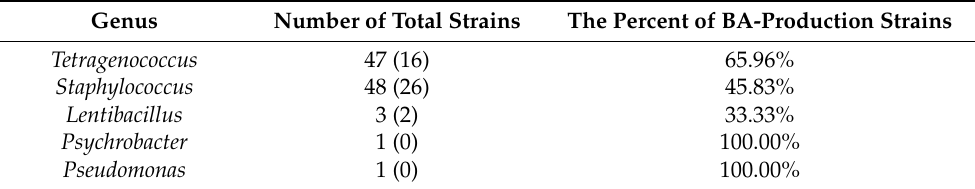
Table 2. Percentage of strains with BA production activities, shown in vitro by the different bacteria species isolated from fermented fish